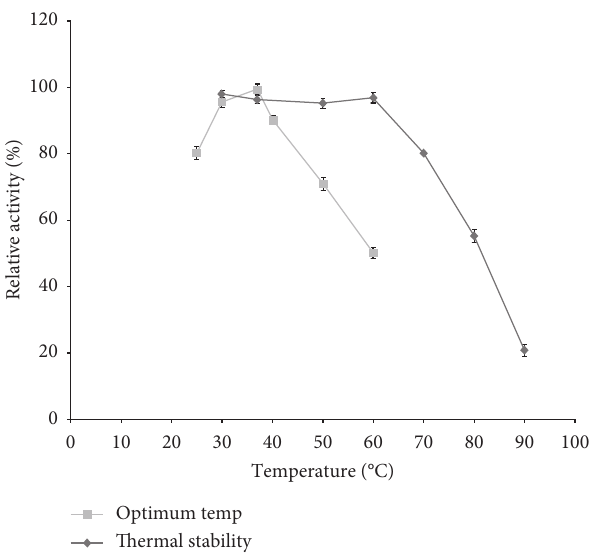
Figure 8: Effect of temperature on the activity and stability of dextranase from Talaromyces sp. Optimum temperature: activity was assayed by the standard method at different temperature values. Thermal stability: activity was assayed by the standard method after incubating the purified dextranase enzyme at different temperatures for 1h without substrate addition. Error bars represent standard errors.